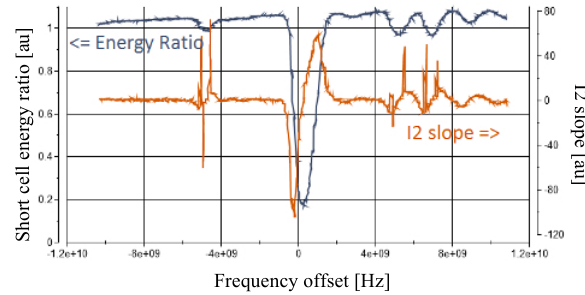
Figure 2: Transmission through the I2 cell and slope estimate versus frequency offset from I2 1109.